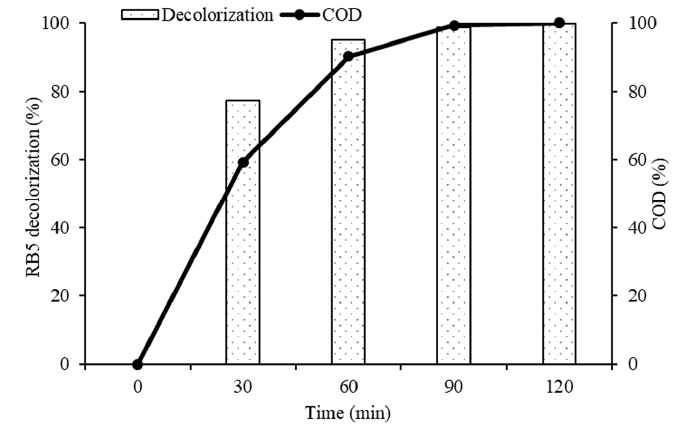
Figure 16. COD removal (%) at different time intervals using the 20N–TiO 2 -300 photocatalyst.